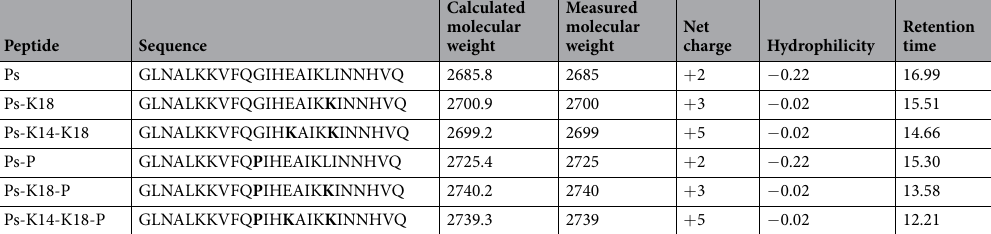
Table 1. Amino acid sequences and properties of the peptides. Hydrophilicity is the total hydrophilicity (sum of all residue hydrophilicity indices) divided by the number of residues, according to the Hopp and Woods index 54